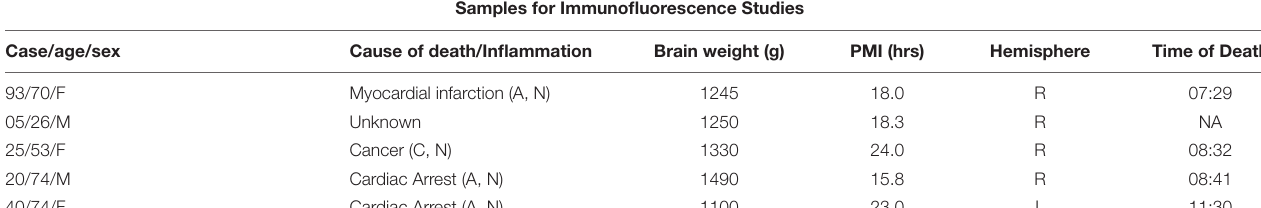
TABLE 1 | Sample demographic and descriptive characteristics of the cohort used for immunohistochemical investigations. Samples for Immunofluorescence